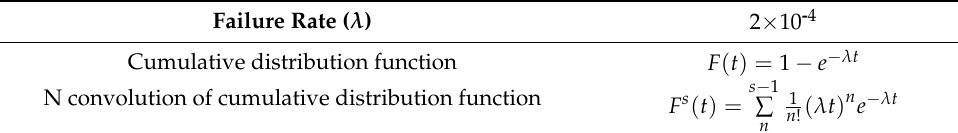
Table A1. Parameters of spare part lifetime